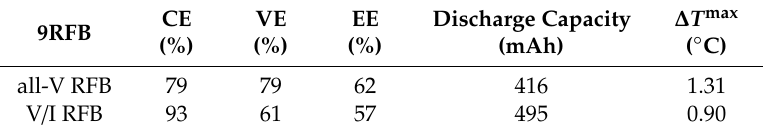
Table 2. Thermodynamic data for vanadium and iodine compounds at 298.15 K. Formula State ∆𝑯 𝒇𝒐 (kJ/mol)